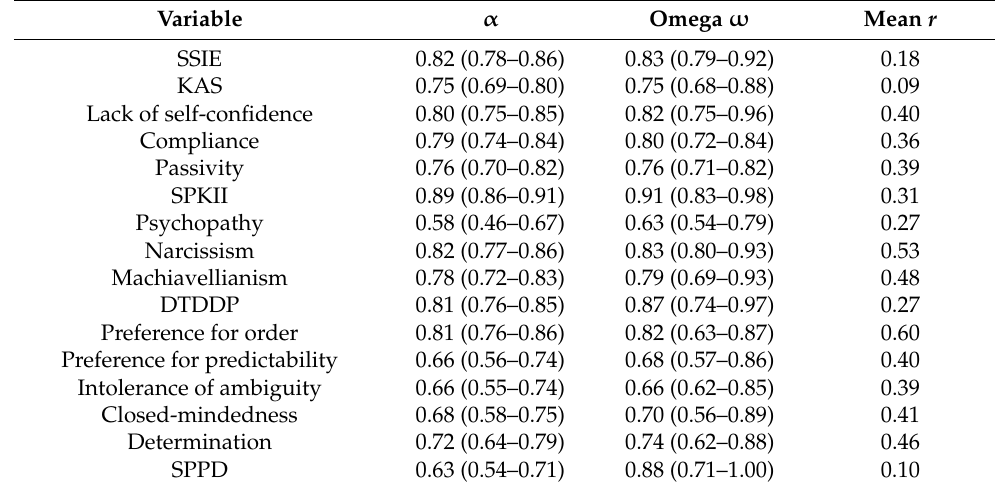
Table 1. Reliability